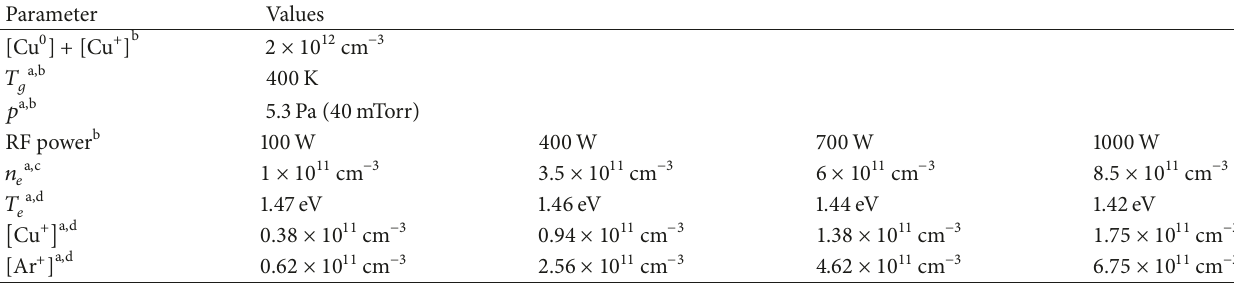
Table 2: Parameters and results of global model.